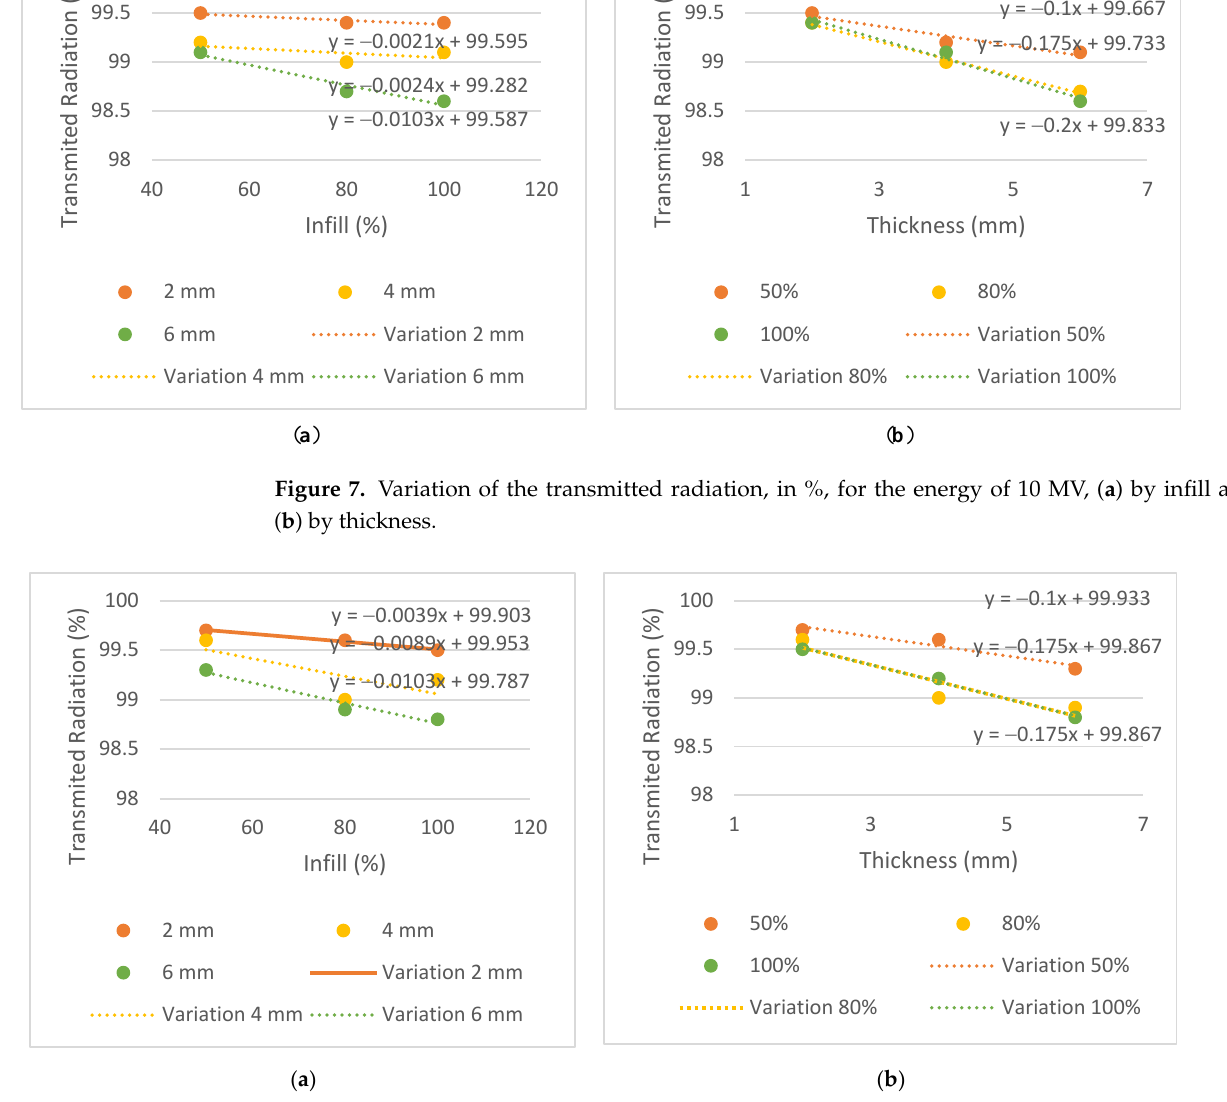
Figure 8. Variation of the transmitted radiation, in %, for the energy of 15 MV, ( a ) by infill and ( b ) by thickness.